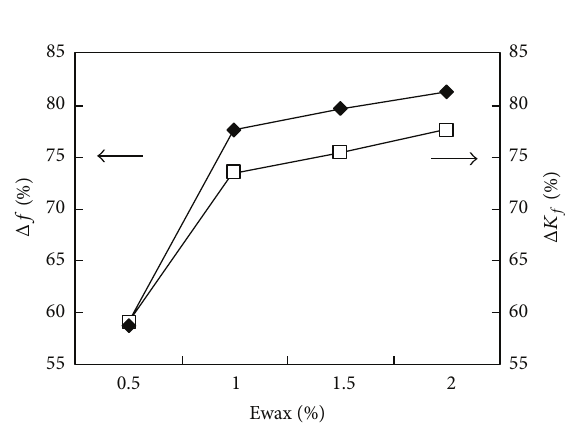
Figure 2: Effect of Ewax additive dosage on lubrication.